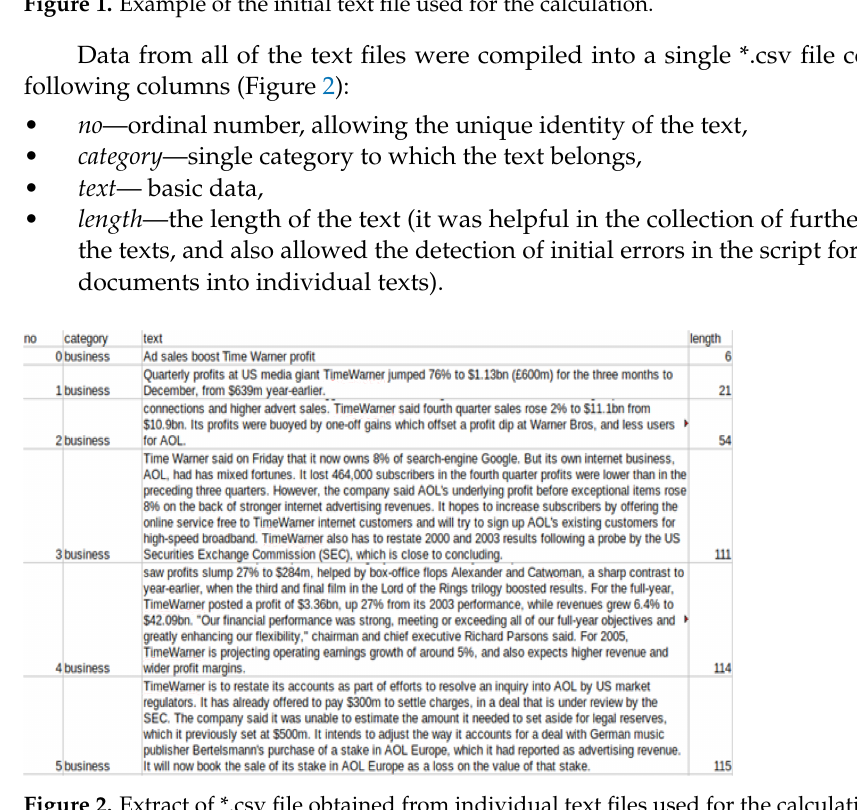
Figure 2. Extract of *.csv file obtained from individual text files used for the